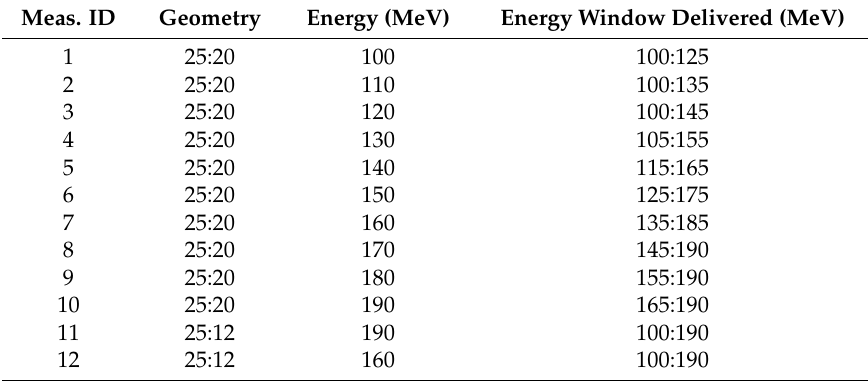
Figure 4. Left : Setup of the benchmark experiment. The proton beam impinges from the top on the water phantom. The PG camera is positioned in its trolley behind the water phantom measuring the PG emission. Right : Beam’s-eye-view of the spot structure of the iso-energy layers. Table 1. Overview of the delivered beams. The camera was aligned to a range R of a specific energy. A window of energies was delivered for each measurement.